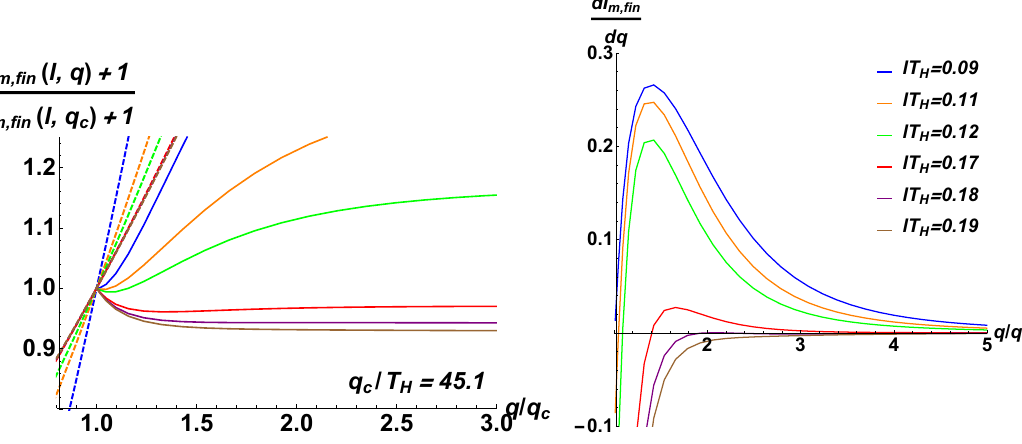
Figure 7 . Normalized entanglement entropy as a function of q=q c for g 2 entanglement entropy for 6 di(cid:11)erent invariant sub-system sizes lT H (from top to bottom, lT H = 0 : 09 ; 0 : 11 ; 0 : 12 ; 0 : 17 ; 0 : 18 ; 0 : 19) with a (cid:12)xed temperature T H = 0 : 15. The dashed and solid curves are for uncondensed and condensed phases, respectively.